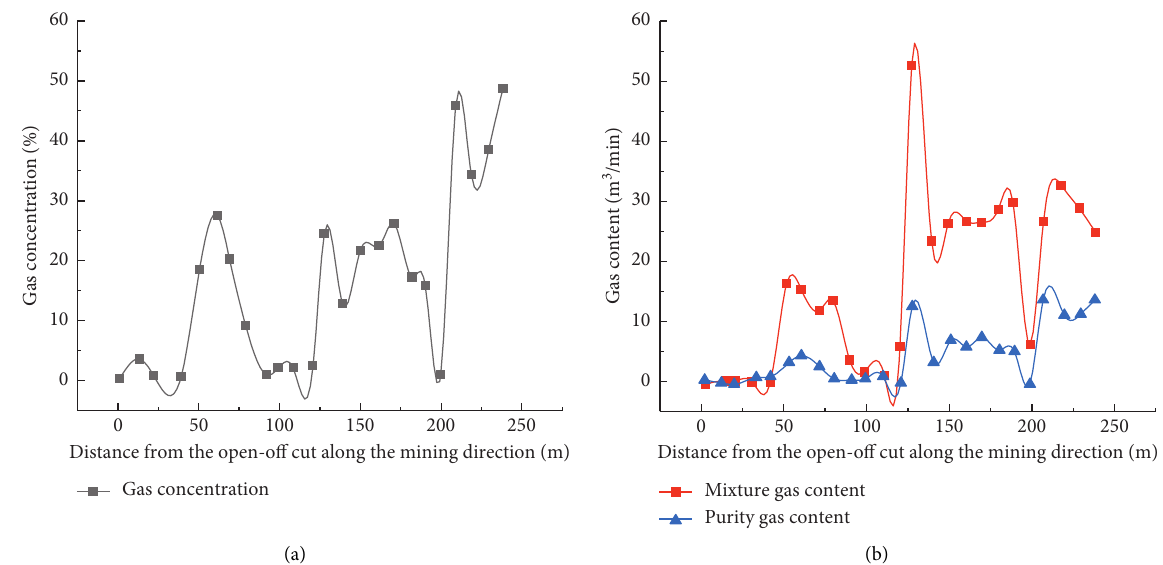
Figure 14: Variation law of extraction parameters of the main drainage pipe in 3307B bottom drainage roadway. (a) Gas concentration; (b) gas